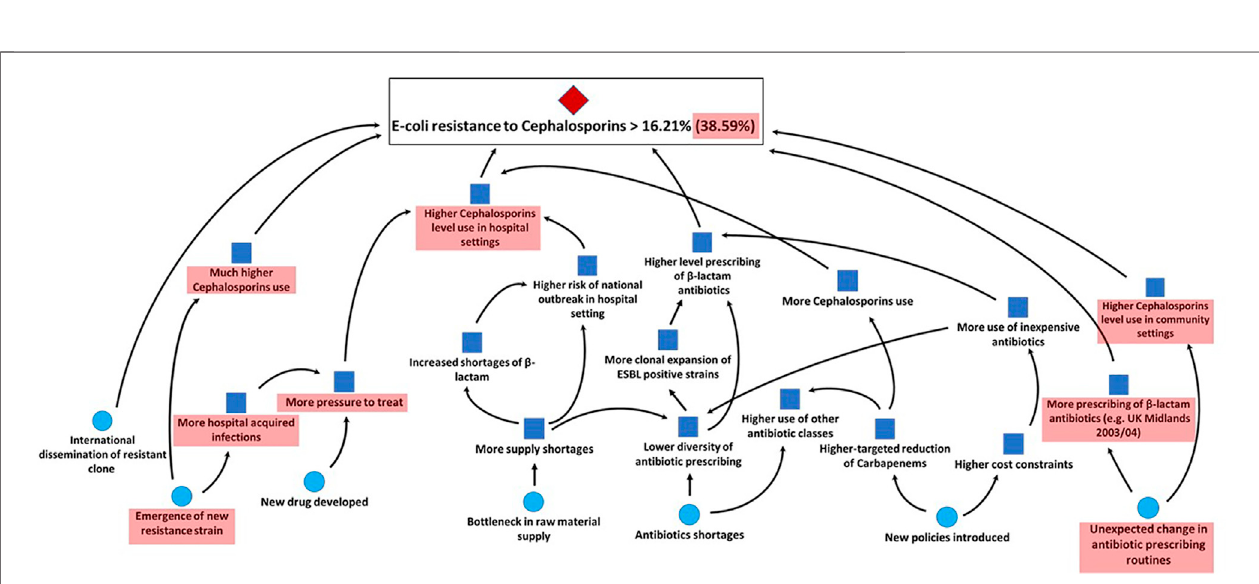
Frontiers in Applied Mathematics and Statistics |